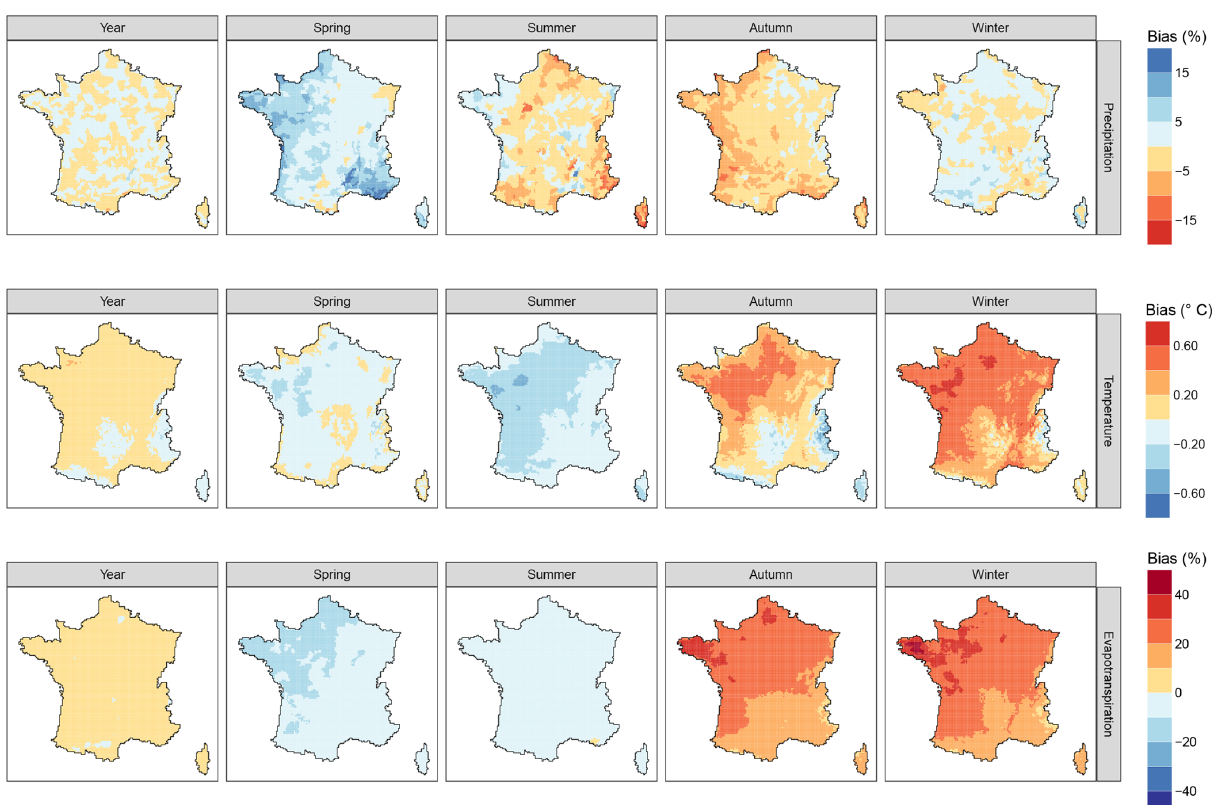
Figure 9. Median of annual and seasonal precipitation (top row), temperature (middle row), and evapotranspiration (bottom row) bias between Safran and SCOPE Climate for the 1959–2007 period. Red corresponds to an overestimation of the reconstructed temperature and reference evapotranspiration as well as an underestimation of the reconstructed